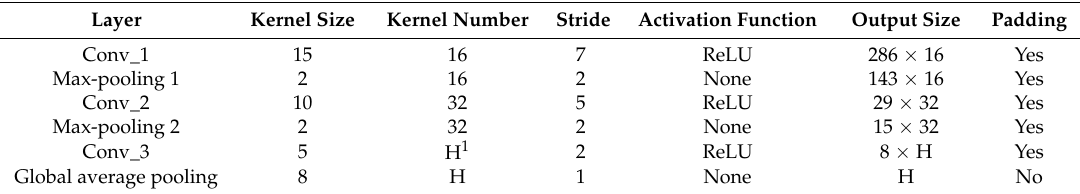
Figure 3. Architecture of AICNN-1D. Table 2. Details of AICNN-1D.